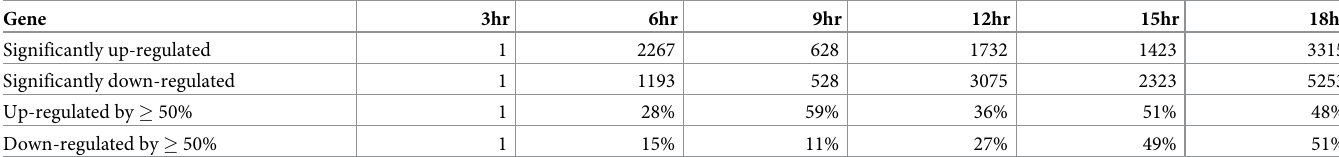
Table 1. The numbers and percentages of microarray probes with significant (false discovery rate < 0.05) differential expression and significant differences by at least 50% between infected and non-infected macrophages, respectively, during the first 18 hours of ASFV infection.